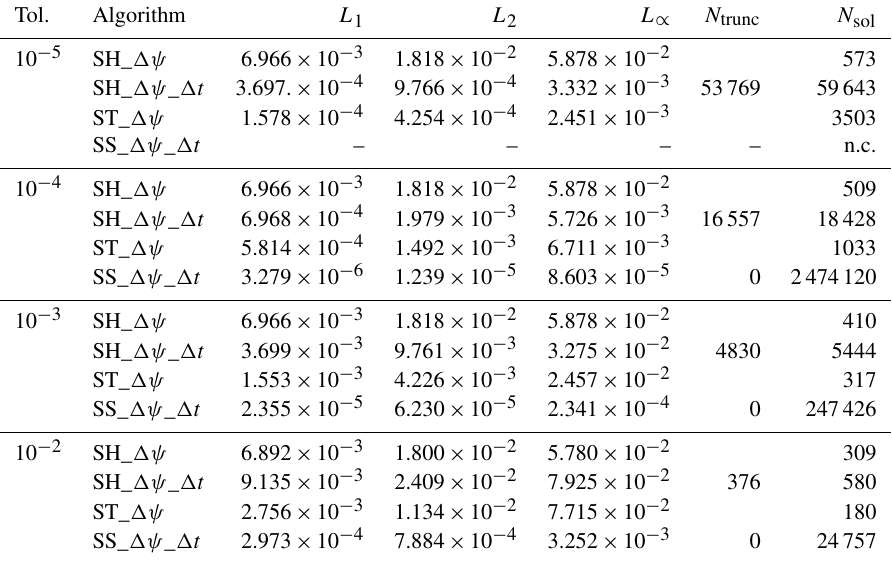
Table 5. Relative errors and number of iterations obtained for the iterative algorithm depending on different convergence criteria for TC2 (n.c.: non convergence in less than 10 7 iterations). Tol.